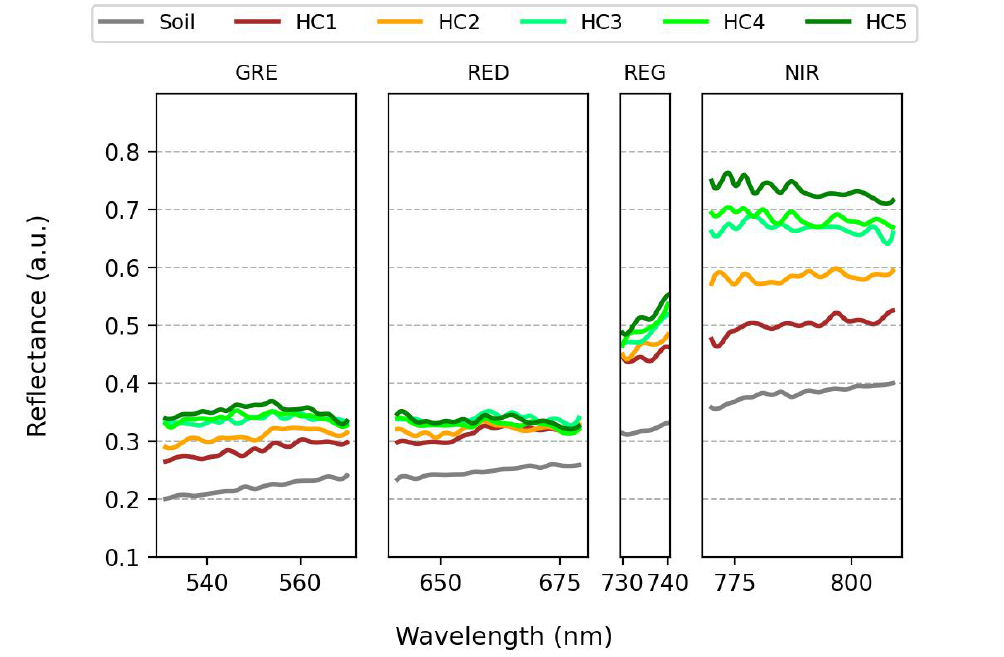
Figure 3. Plant health classes. Phenotype traits for each plant